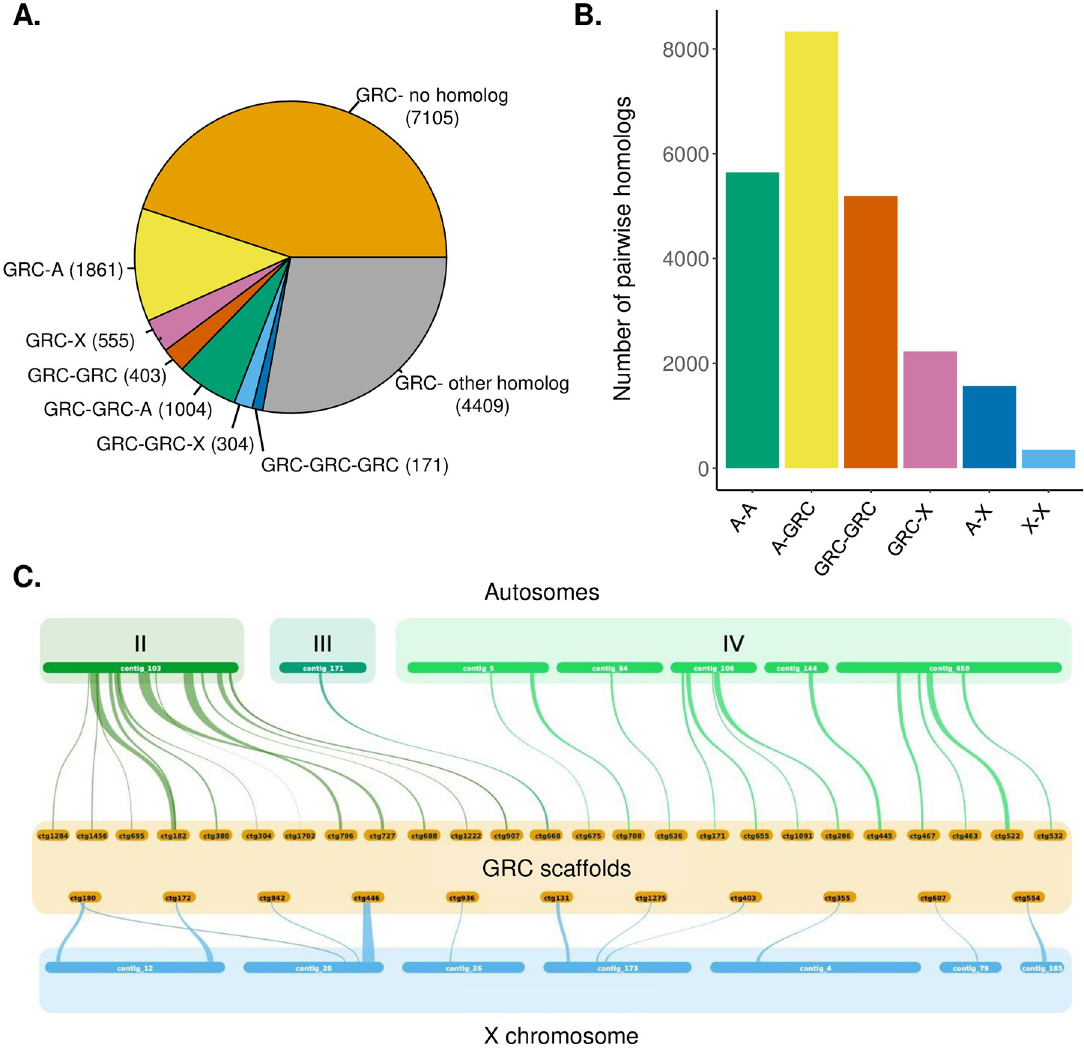
Fig 2. Many GRC genes have divergent homologs distributed throughout the core genome. (A) Number of GRC genes with no homologs, 1 homolog (and the location of that homolog), 2 homologs, or more homologs in the B . coprophila genome identified through a reciprocal blast analysis. Homologs in the GRC-other category either have multiple homologs (i.e., homologs with more than 4 genes with reciprocal blast hits to each other) or homologs with some genes on unclassified scaffolds. (B) Number of homolog pairs in the B . coprophila genome and chromosomal location of homologs. (C) Collinear blocks found between GRC scaffolds (orange) and scaffolds anchored to the X chromosome (blue) or individual autosomes (A-II, A-III, or A-IV; shades of green). Note that there is variation in the reference assembly in the proportion of scaffolds that are anchored to each chromosome ( S4 Table ). Location of data used to generate Fig 2A and 2B is specified in S1 Table . GRC, germline-restricted